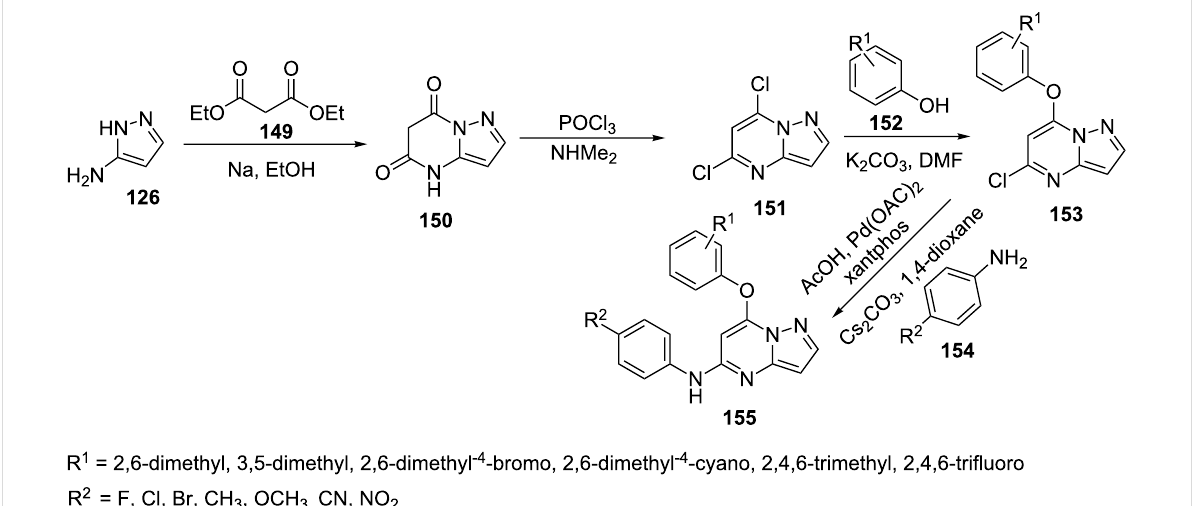
Scheme 43: Synthesis of N -(4-aminophenyl)-7-aryloxypyrazolo[1,5- a